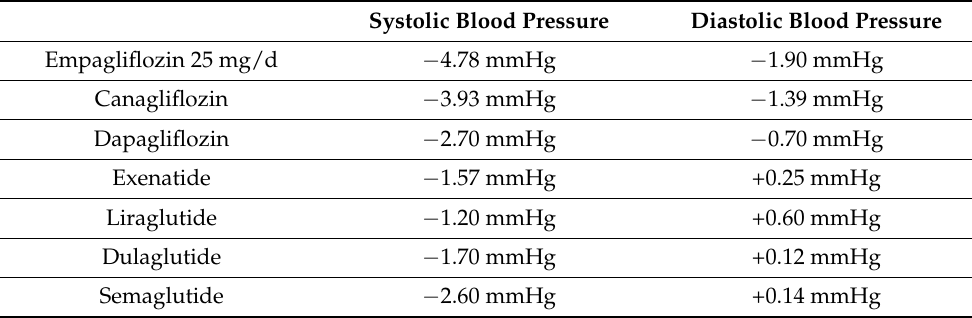
Effects of specific SGLT-2 inhibitors and GLP-1 analogues on blood pressure